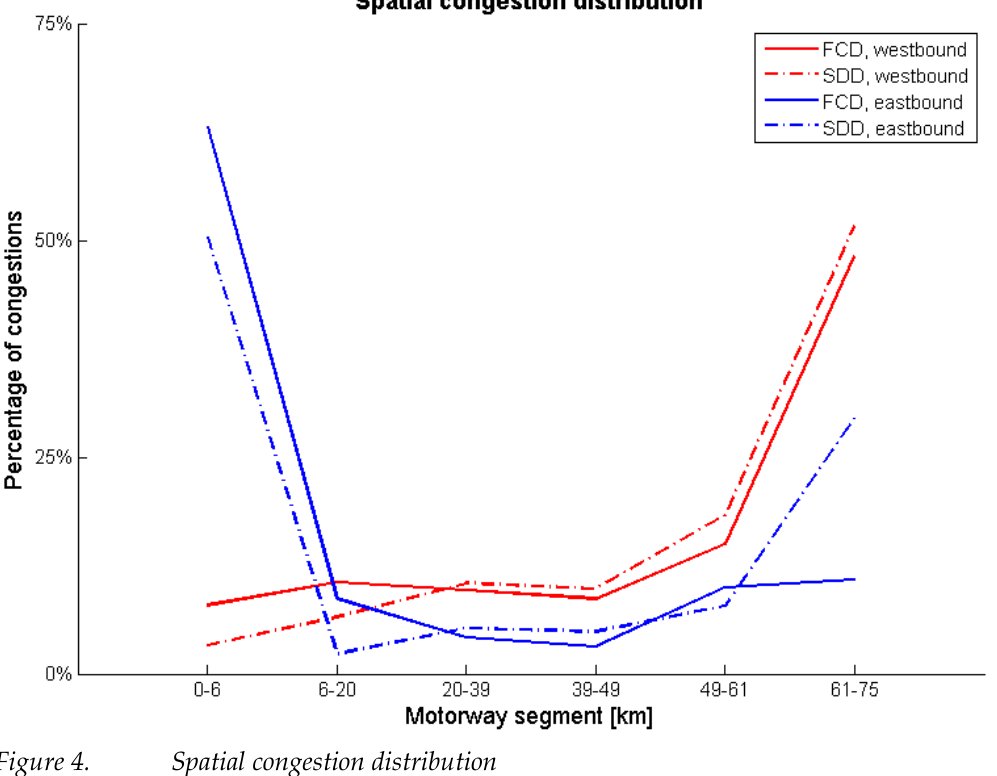
Figure 4. Spatial congestion